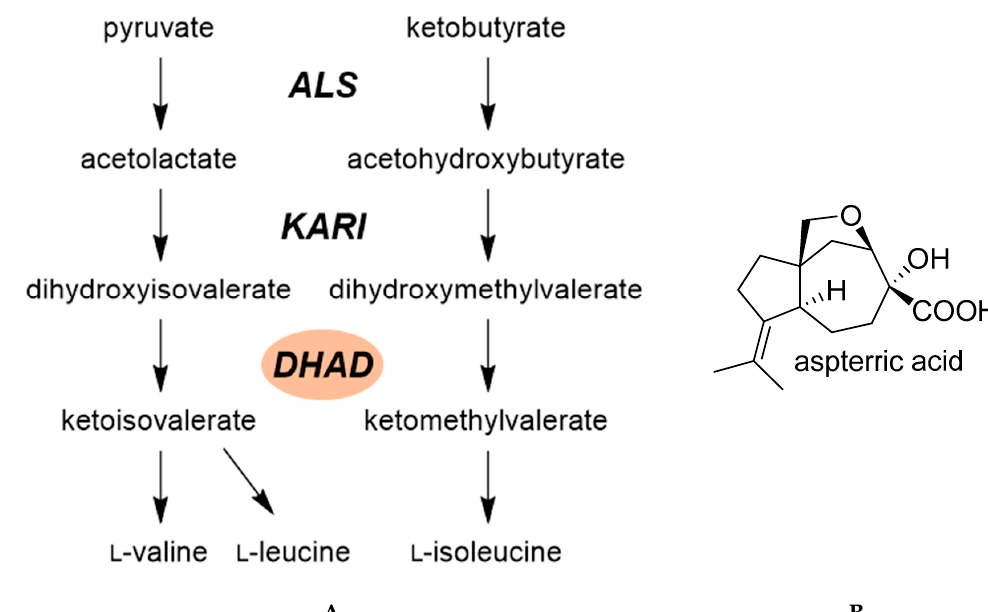
Figure 5. ( A ) Key enzymes involved in branched chain amino acid biosynthesis. DHAD is the